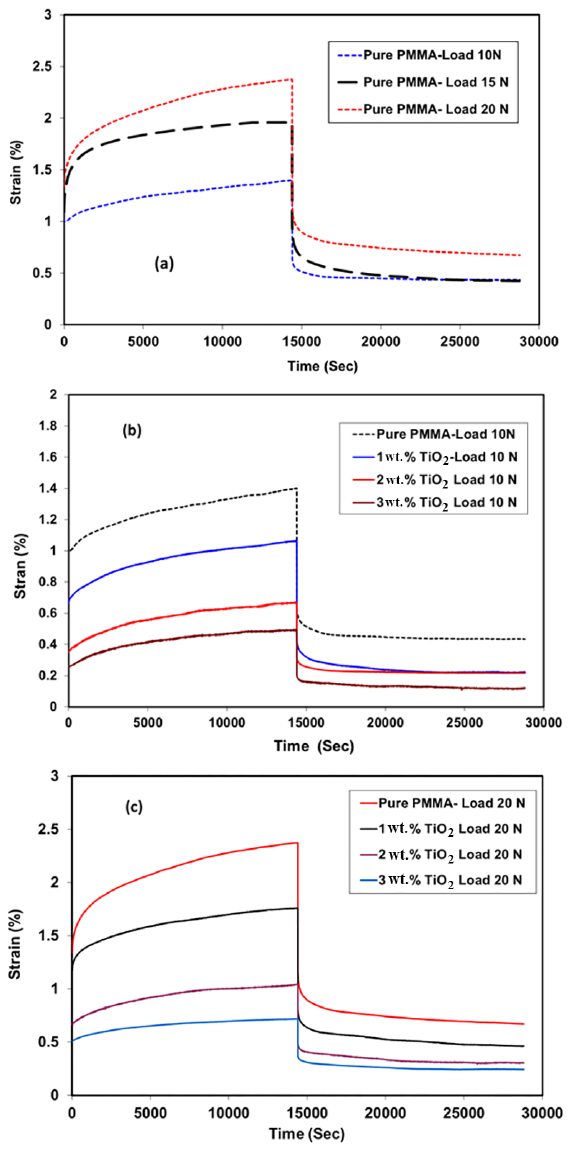
Figure 5. Creep-recovery behavior of PMMA and its nanocomposites at different loads for 0 wt. %, 1 wt. %, 2 wt. %, and 3 wt. % TiO 2 NPs.